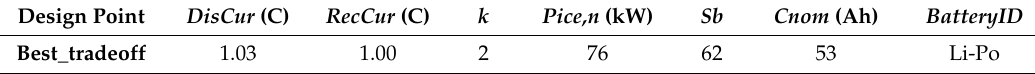
Table 7. Specification of the “Best_tradeoff” solution of Test Case 2.